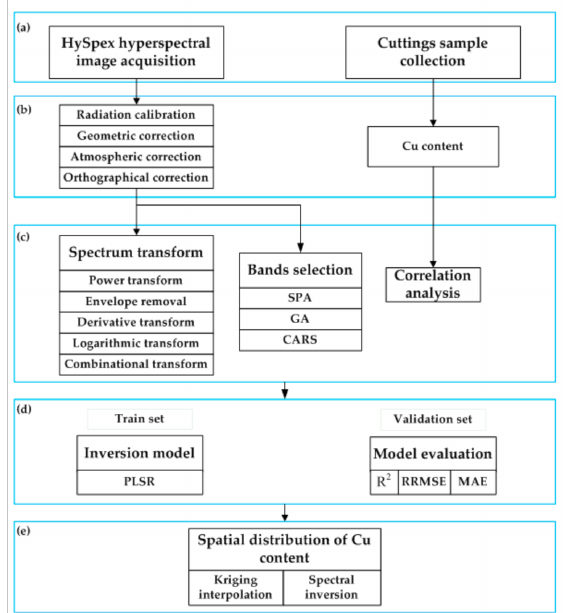
Figure 5. Flowchart of HySpex hyperspectral imagery inversion of Cu content: ( a ) data acquisition; ( b ) data preprocessing; ( c ) data analysis; ( d ) modeling and verification; ( e ) spatial distribution of Cu